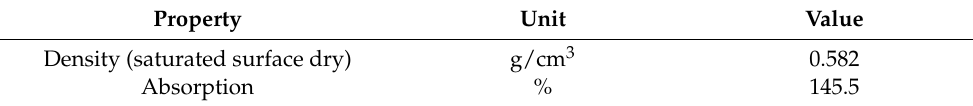
Table 3. Properties of coconut fiber.